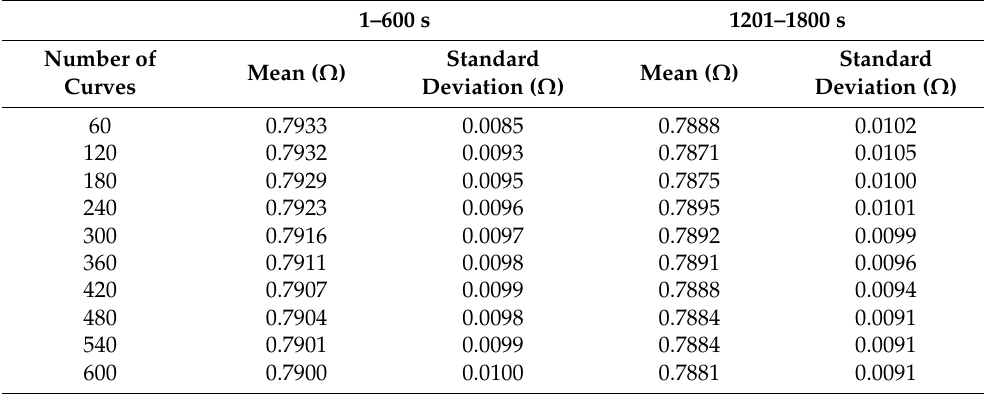
Table 4. Statistics of the fitted series resistance values fitted to entire I – U curves for measurement times of 1–600 s and 1201–1800 s.